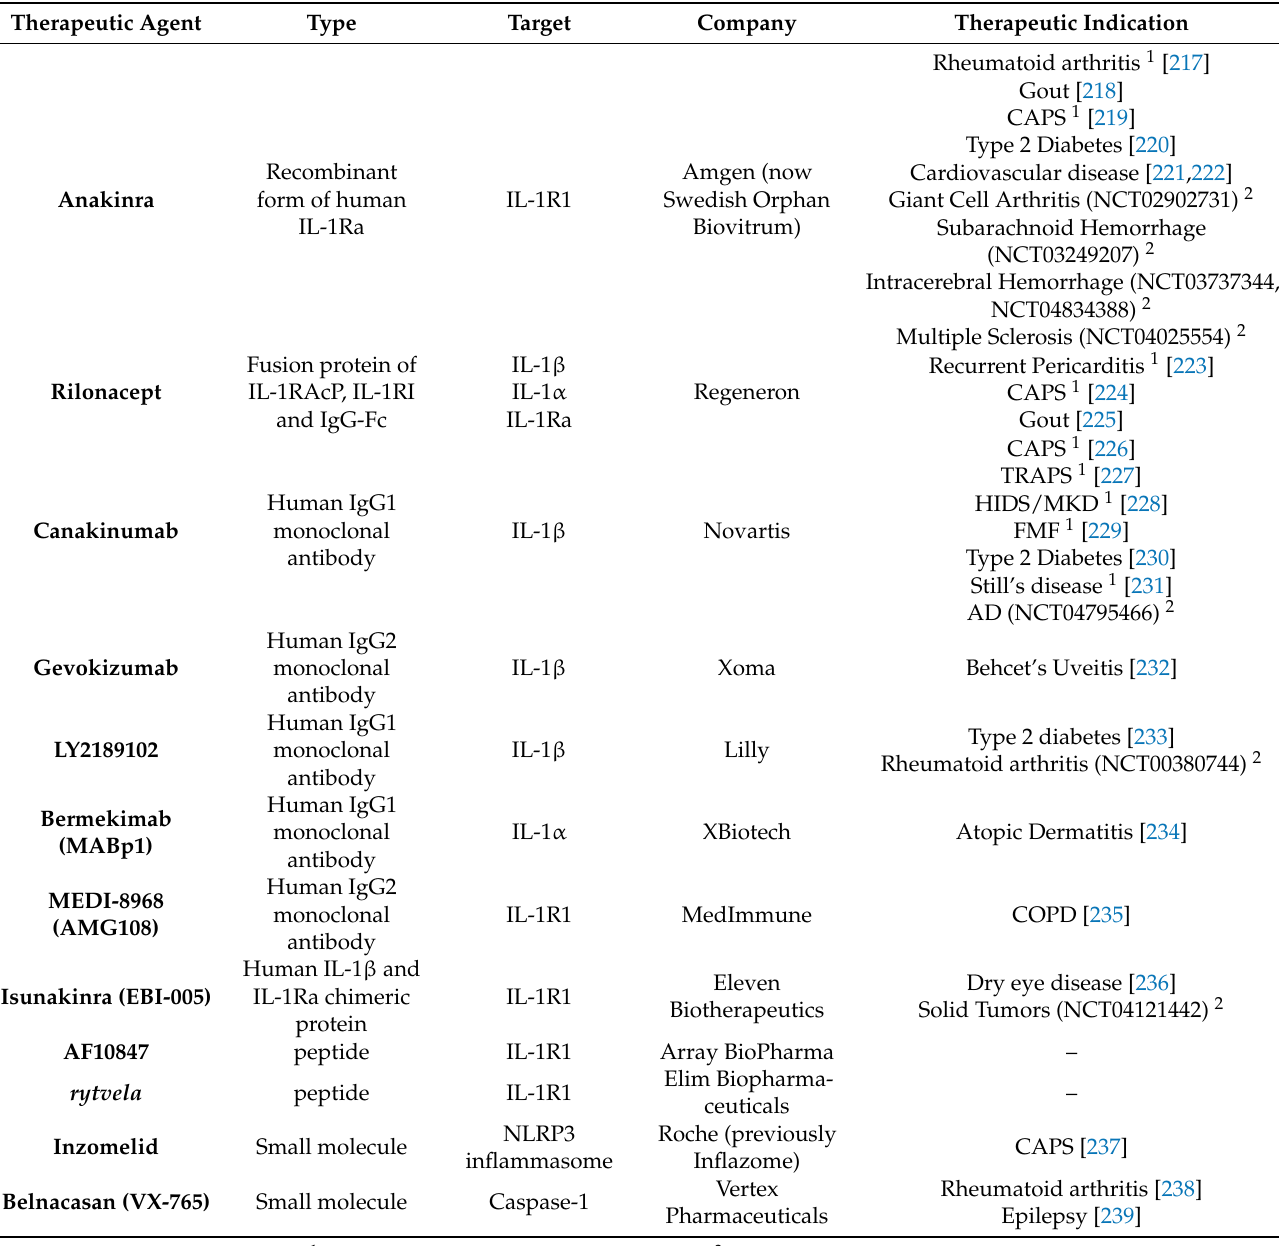
Table 3. Summary of therapeutic agents available for the modulation of IL-1